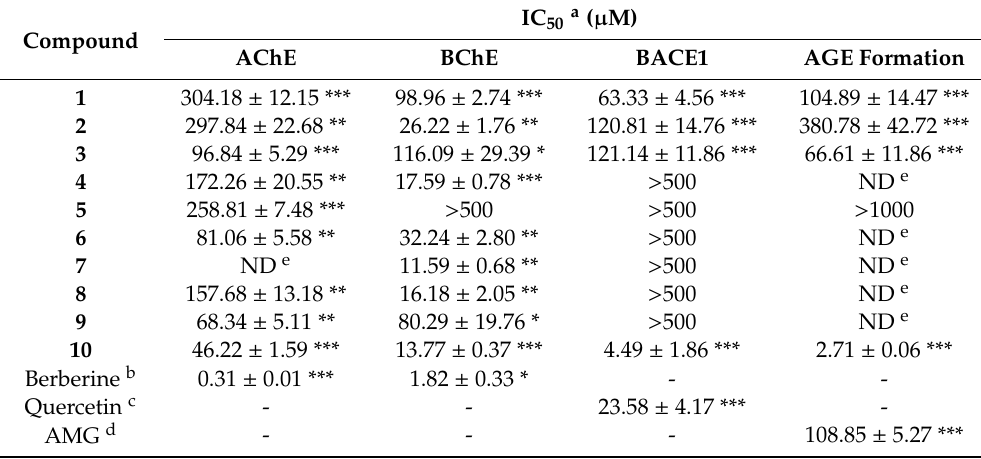
IC 50 of the compounds 1 – 10 for cholinesterase (acetylcholinesterase (AChE) and butyrylcholinesterase (BChE)), β -site amyloid precursor protein cleaving enzyme 1 (BACE1), and the formation of advanced glycation end-product (AGE) inhibition. IC 50 a ( µ M) Compound AChE BChE BACE1 AGE